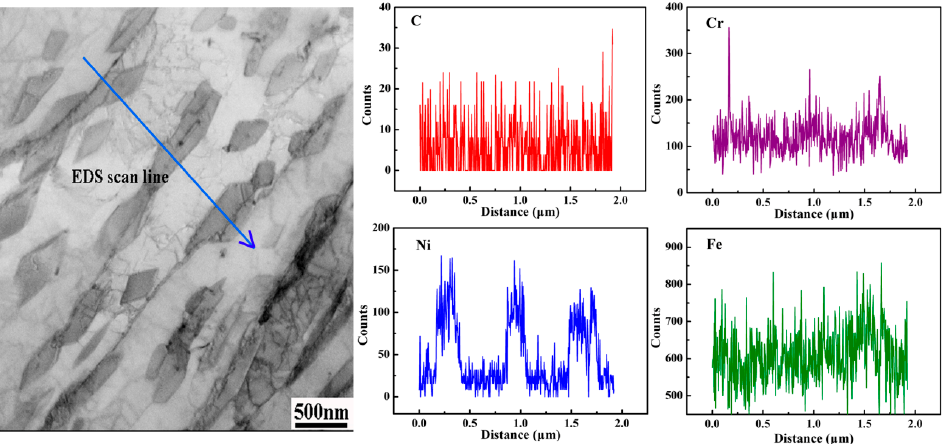
Figure 8. Scanning transmission electron microscopy (STEM) morphology and energy dispersive spectroscopy (EDS) line scanning spectrum of the sample tempered at 620 ◦ C for 16 h. The blue line spectroscopy (EDS) line scanning spectrum of the sample tempered at 620 °C for 16 h. The blue line marks the position of the EDS line scanning in the STEM marks the position of the EDS line scanning in the STEM image.